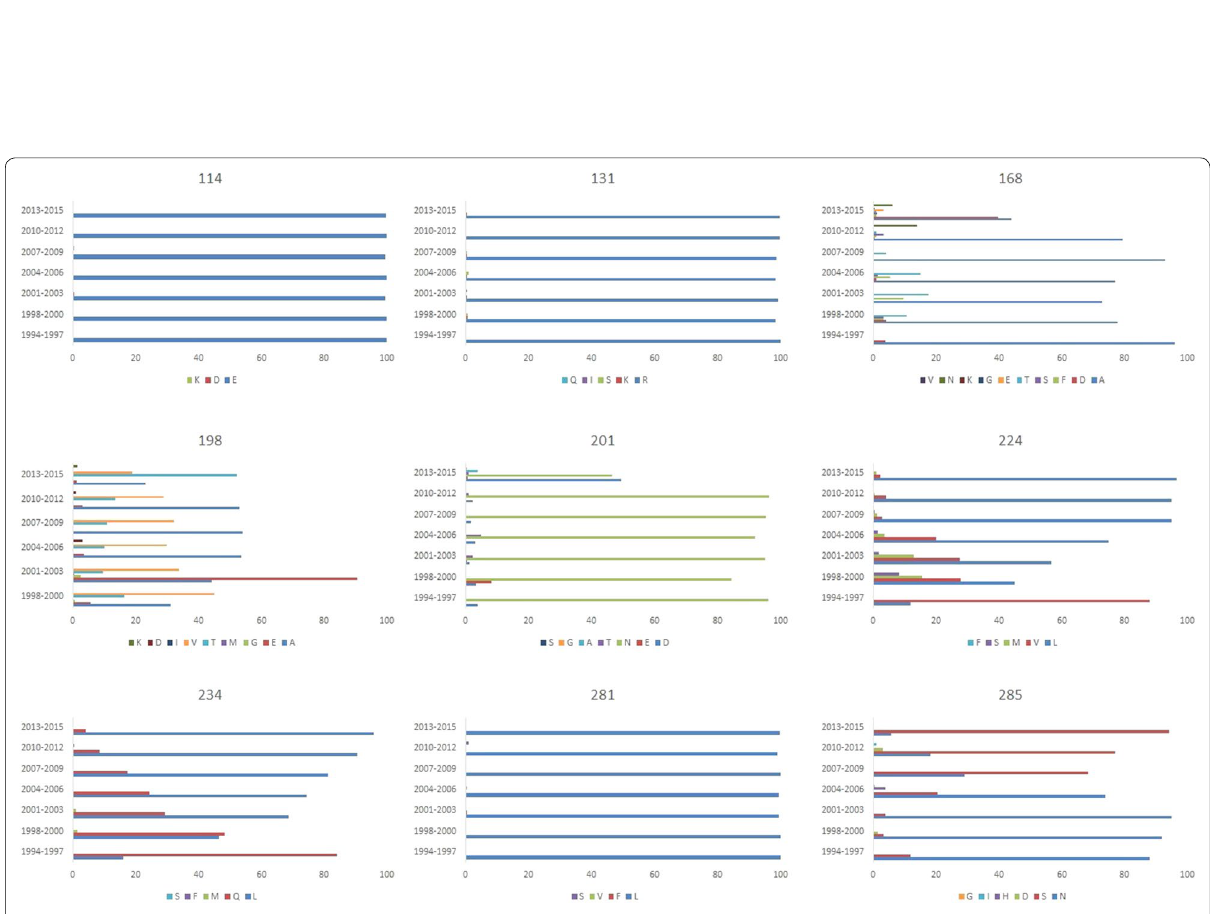
Fig. 5 Hotspots on HA of wild-type H9N2 strains. The HA genes were loaded from GenBank. The Y axis represents the years when the strains were